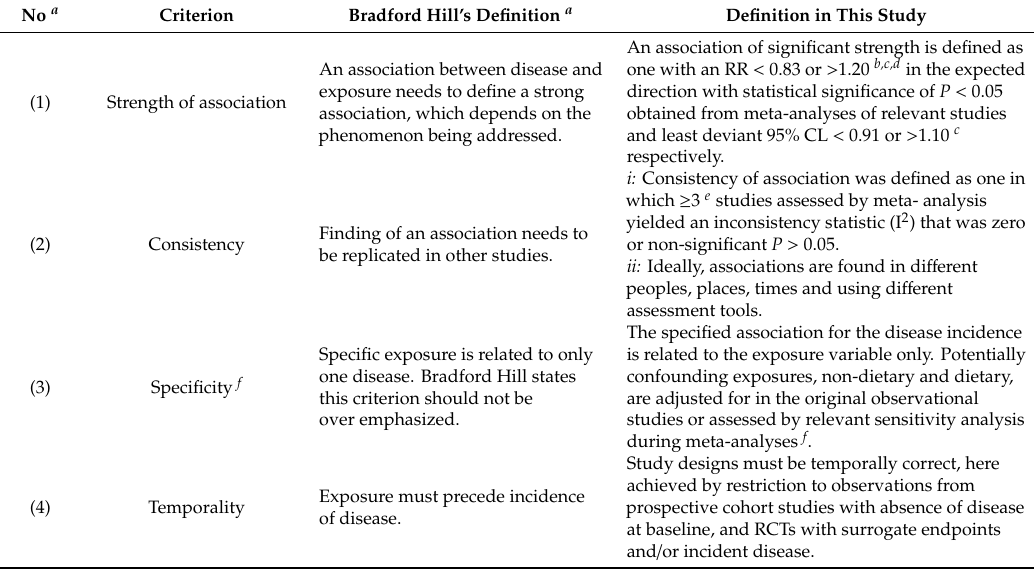
Table 1. Bradford-Hill criteria (1–9) for assessment of causation in prospective cohort studies; definitions used in the present study, and cost–benefits (Point